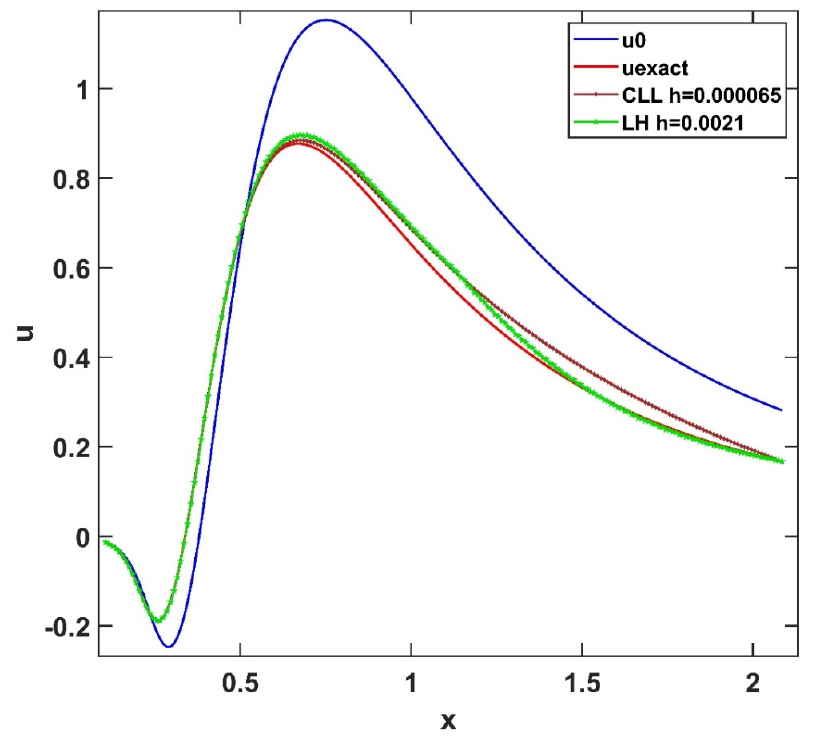
Figure 5. The concentration u as a function of the x variable in the case of the initial function u 0 , the analytical solution at t fin , the CLL method for h = 6.5 · 10 − 5 , and the leapfrog-hopscotch (LH) method for h = 0.0021 for Experiment 1. We emphasize that the conventional Runge–Kutta methods are unstable for these time step sizes.